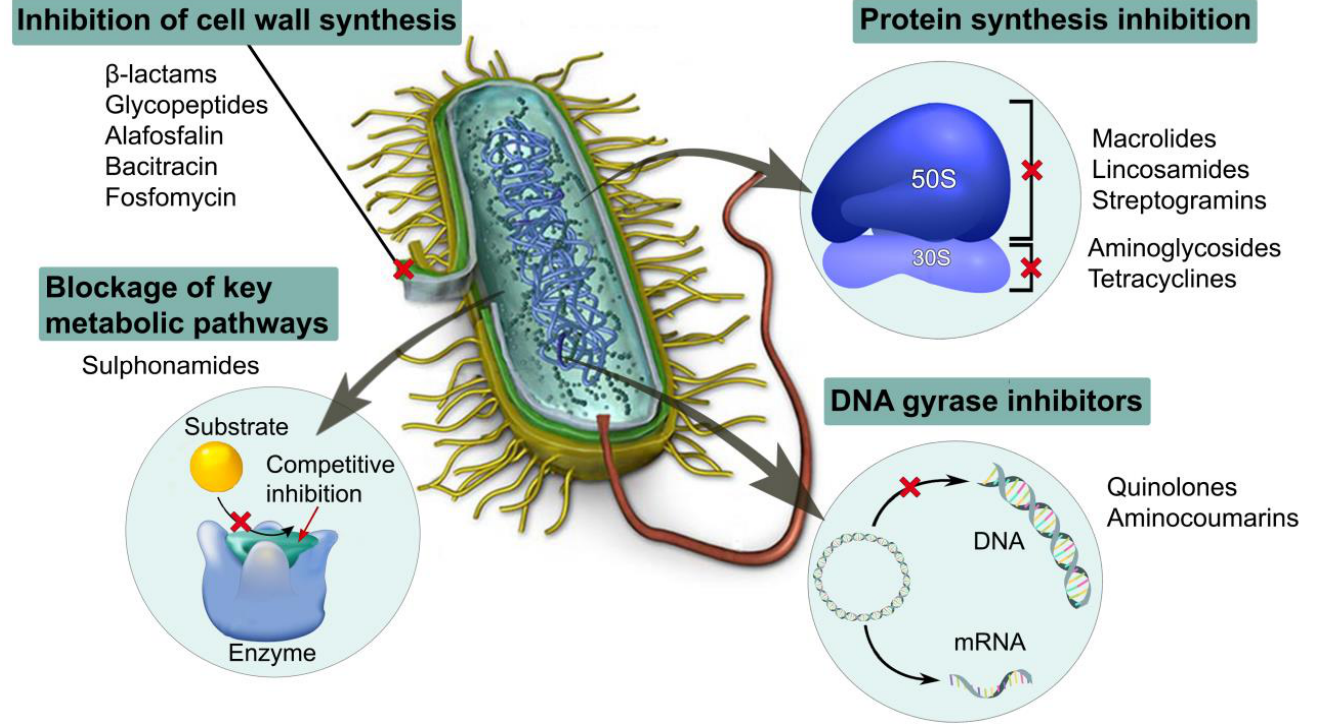
Figure 2. Possible mechanisms of bacterial activity disruption caused by antibiotics (scheme prepared based on the information presented in [46,47]).